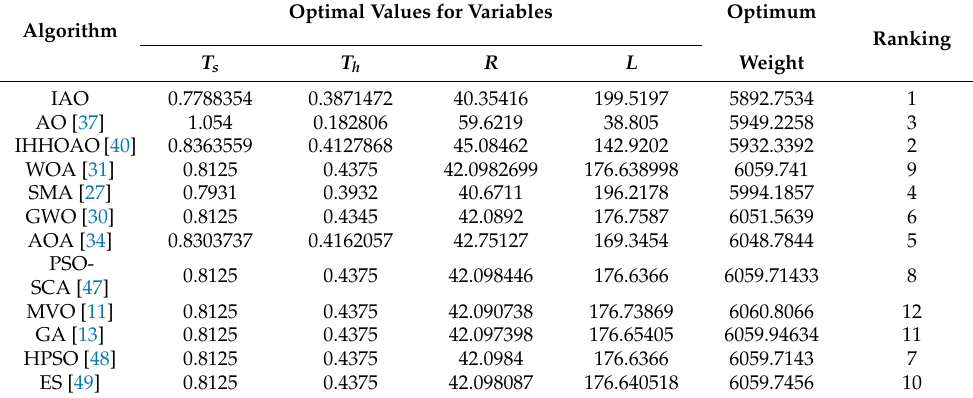
Figure 7. Pressure vessel design problem. Table 14. Results of the compared algorithms for solving the pressure vessel design